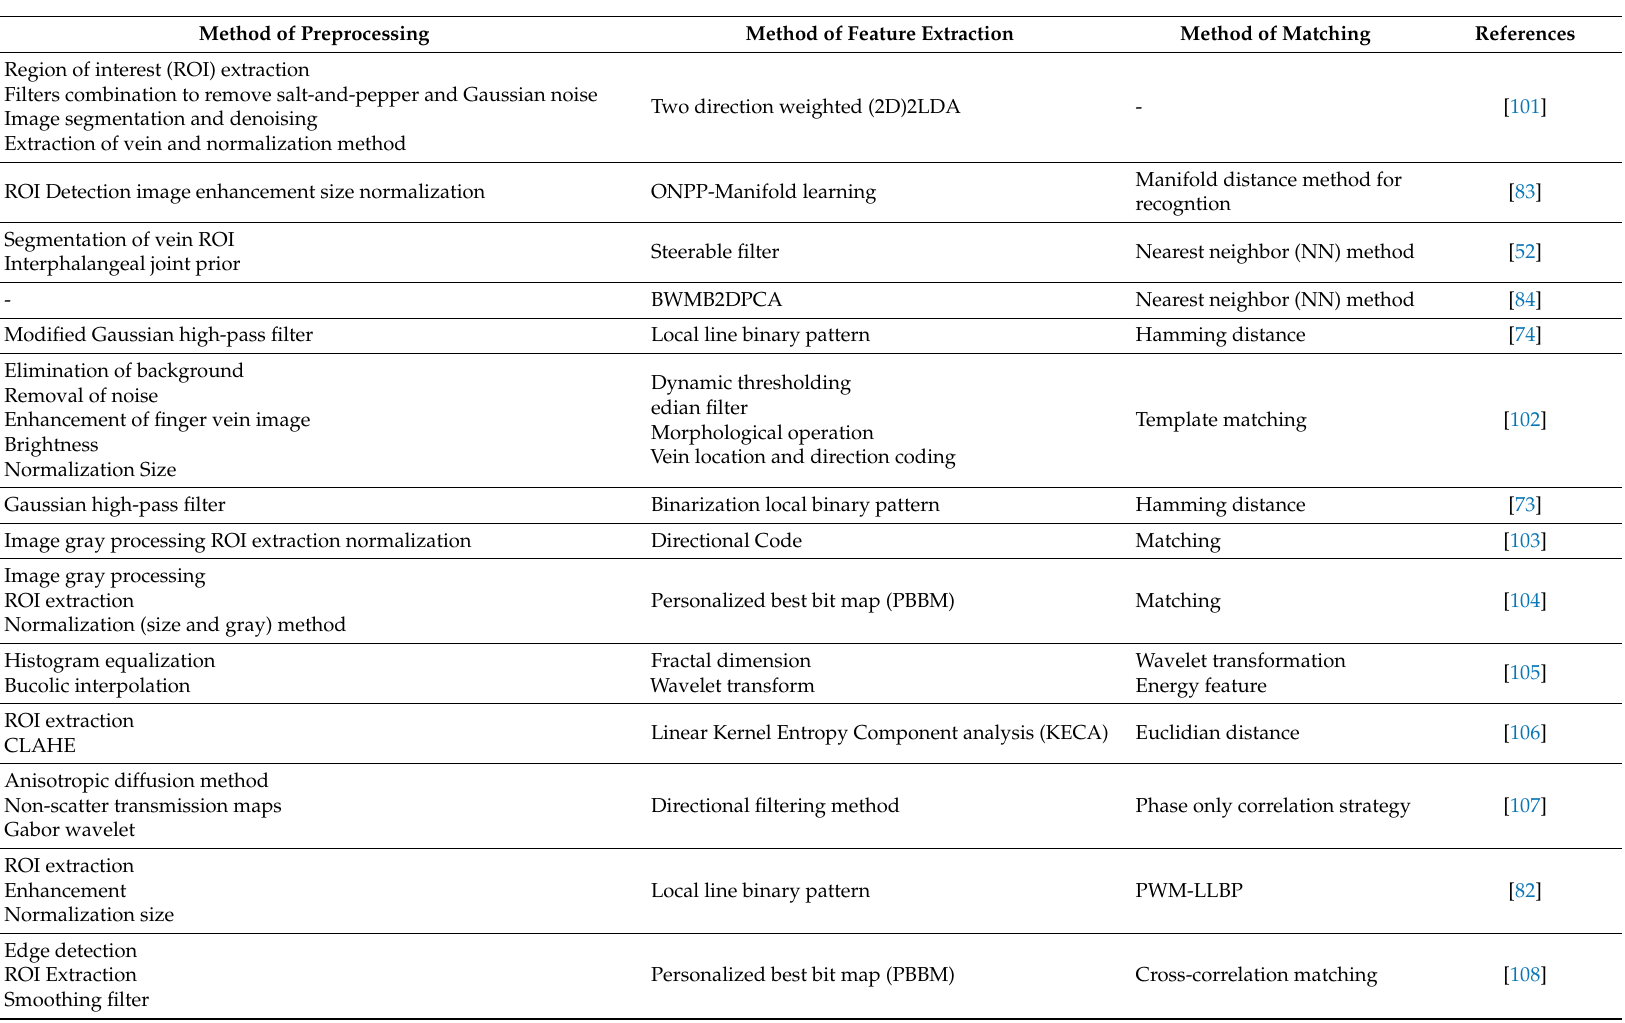
Table 3. Traditional (conventional) method of finger vein